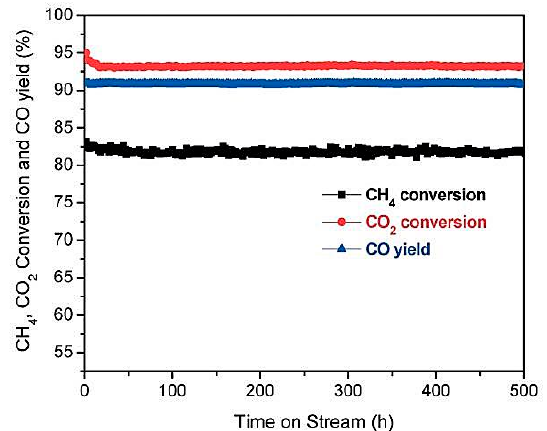
Figure 6. The lifetime test of DRM over the tungsten carbide nanoparticle in biochar matrix at 850 °C, 5 bar, gas hourly space velocity (GHSV) of 6000 h − 1 and a constant feed CH 4 /CO 2 ratio of 1 reproduced from reference [58] with permission from The Royal Society of Chemistry.